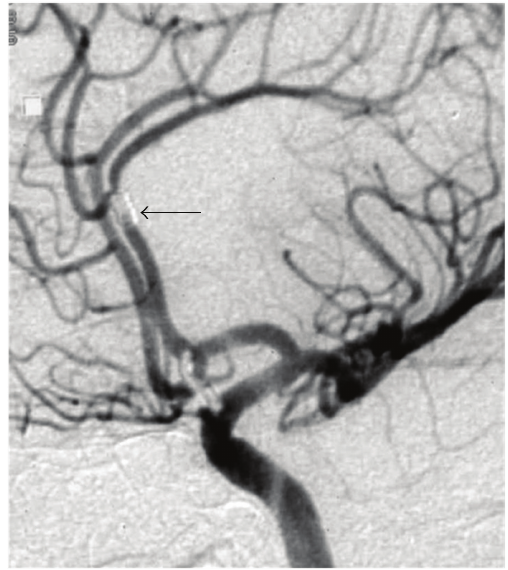
Figure 2: Left ICA DSA after aneurysm has been clipped showing that the helical coil (arrow) is in the pericallosal artery with good distal blood